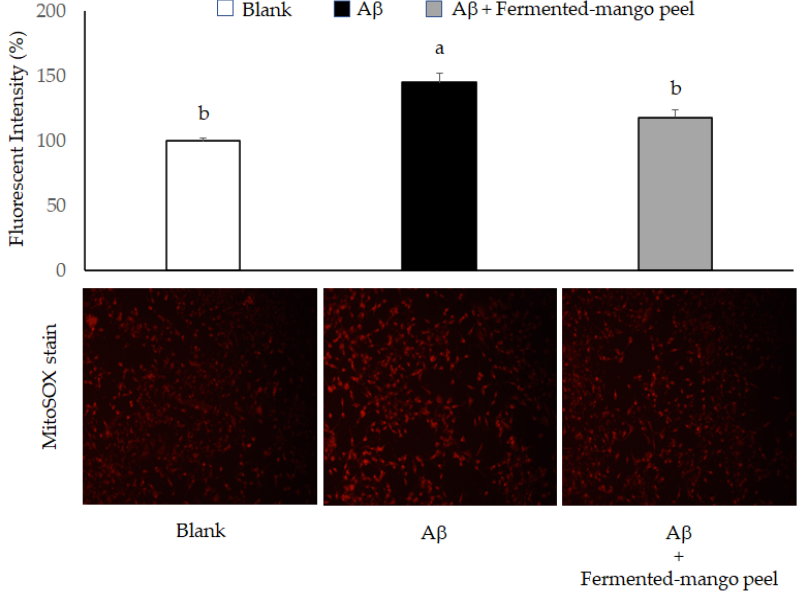
Figure 6. The attenuation of oxidative stress in A β -induced Neuron-2A cells by L. acidophilus (BCRC14079)-mango peel extracts (100 μ g/mL) treatment for 36 h. Data are shown as means ± SD ( n = 3). Significant differences are shown by various letters ( p < 0.05).